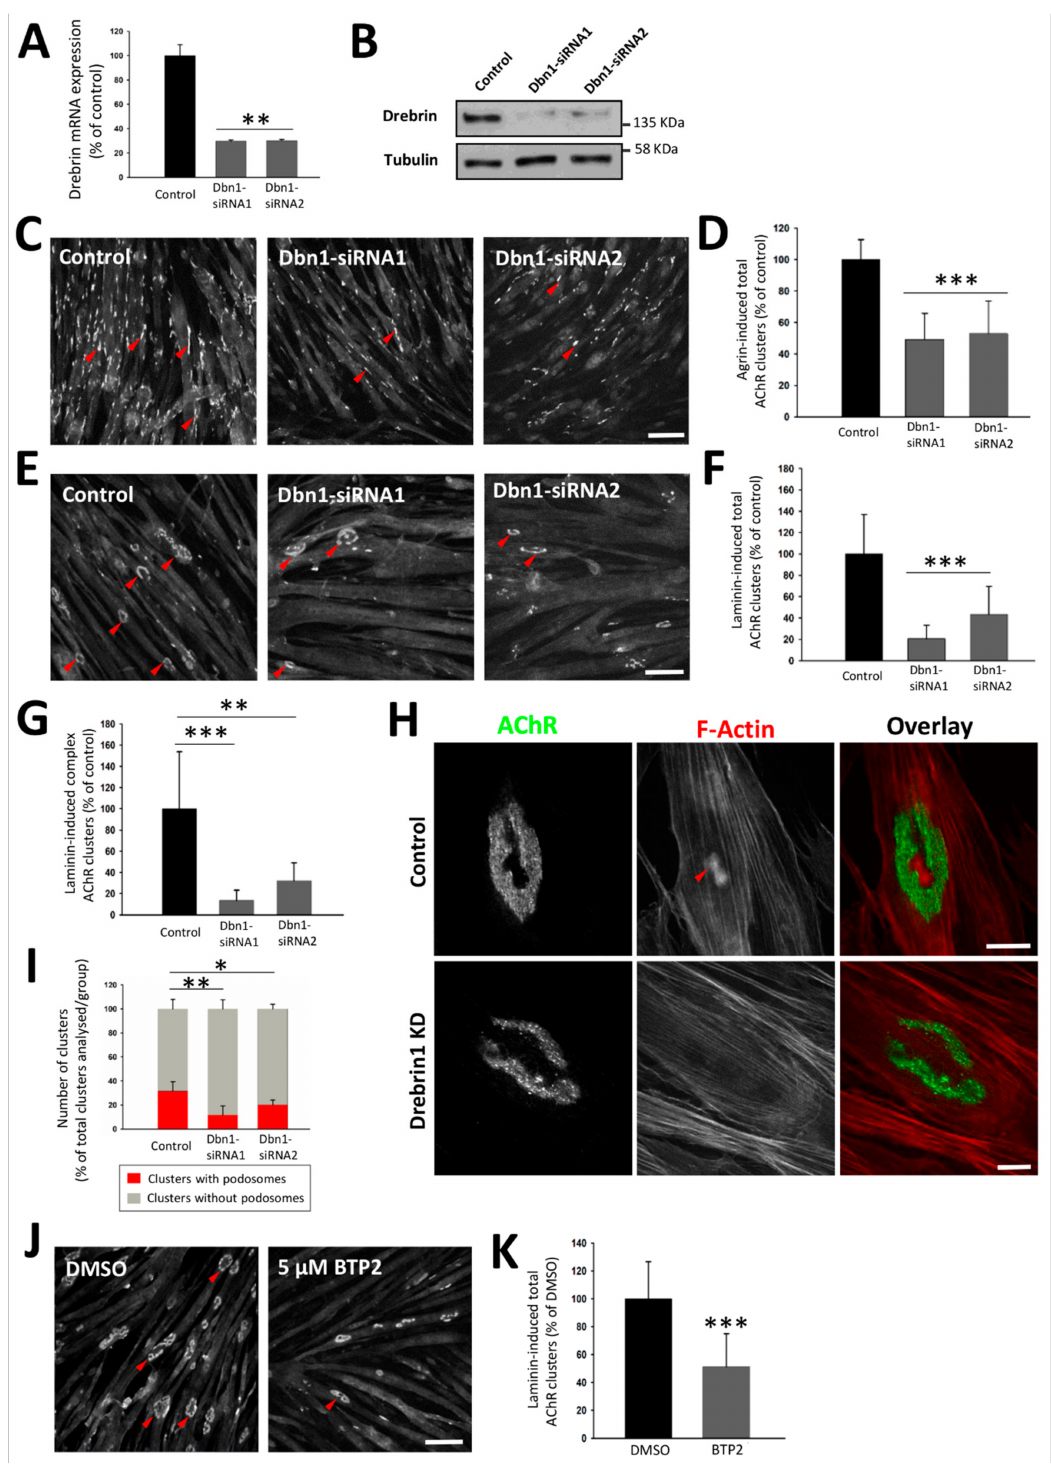
Figure 4. siRNA-mediated drebrin downregulation and inhibition of drebrin binding to F-actin with 3,5-bis-trifluoromethyl pyrazole (BTP2) impair AChR clustering in vitro. ( A , B ) Drebrin1 knockdown validation with RT-qPCR ( A ) and Western blot ( B ). ( C ) Agrin-induced AChR clusters labeled with BTX in C2C12 myotubes transfected with Dbn1-siRNAs. Red arrows indicate AChR clusters. ( D ) Quantification of the total number of agrin-induced AChR clusters in drebrin-depleted myotubes. ( E ) Laminin-induced AChR clusters labeled with BTX in C2C12 myotubes transfected with Dbn1-siRNAs. Red arrows indicate AChR clusters. Scale bars—100 µ m. ( F ) Quantification of the total number of laminin-induced AChR clusters in drebrin-depleted myotubes. ( G ) Quantification of the number of laminin-induced complex AChR clusters in drebrin-depleted myotubes. Data are presented as a percentage of control (myotubes transfected with non-targeting